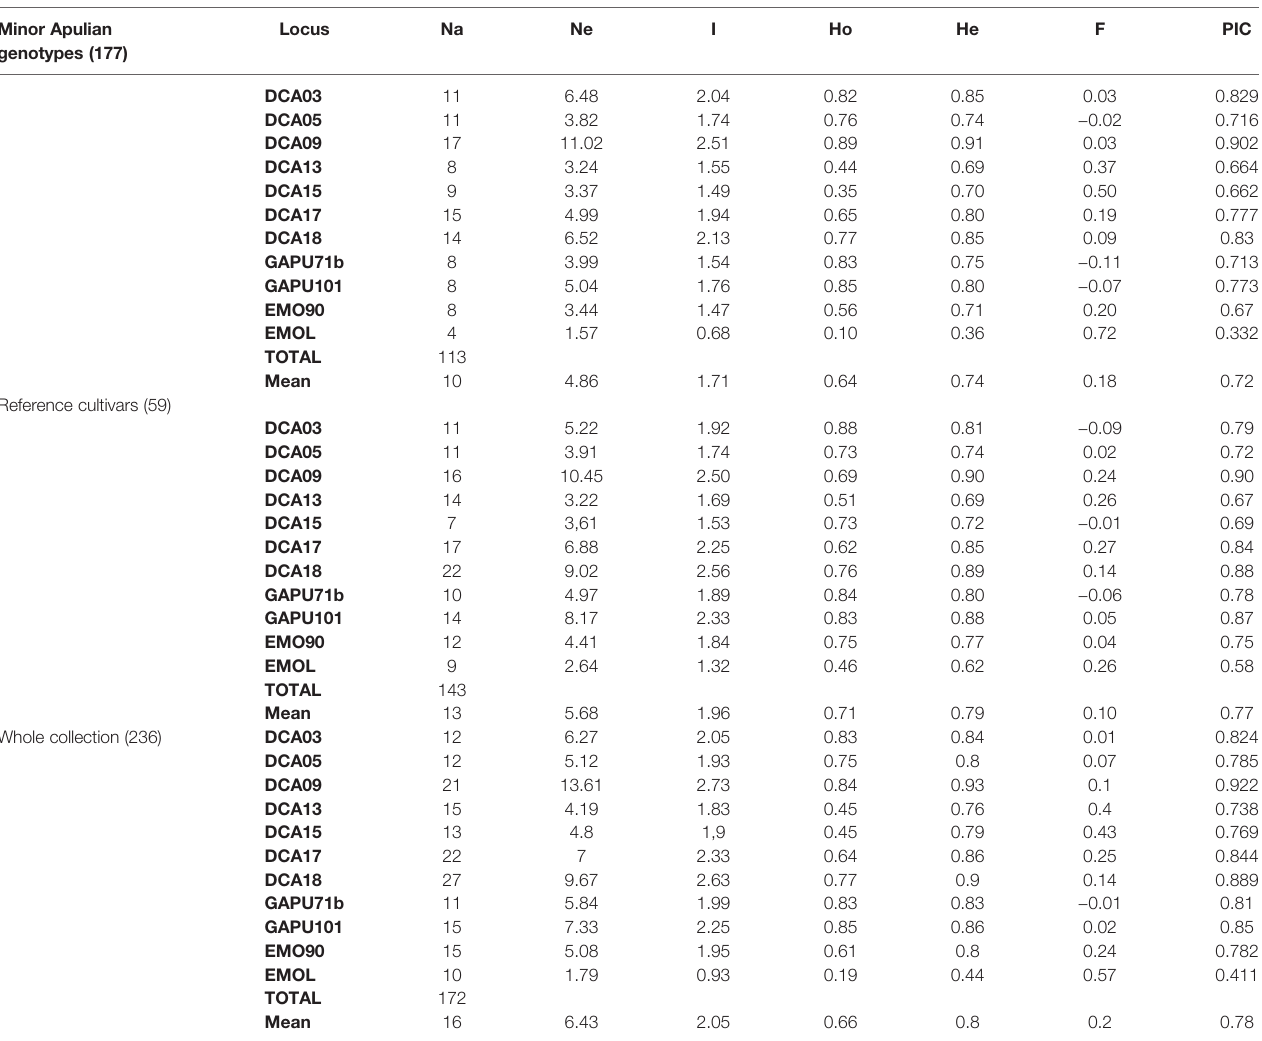
TABLE 2 | Genetic indices obtained by SSR analysis on 177 minor Apulian accessions. Minor Apulian Locus Na Ne I Ho genotypes (177)